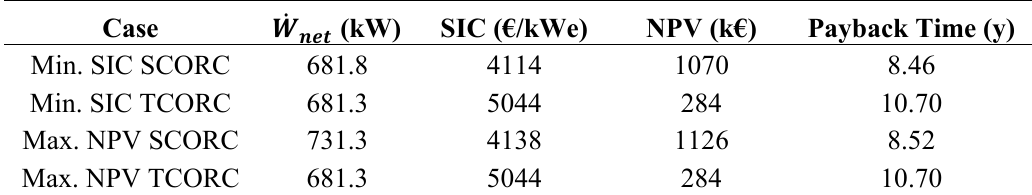
Table 12. Results of the NPV